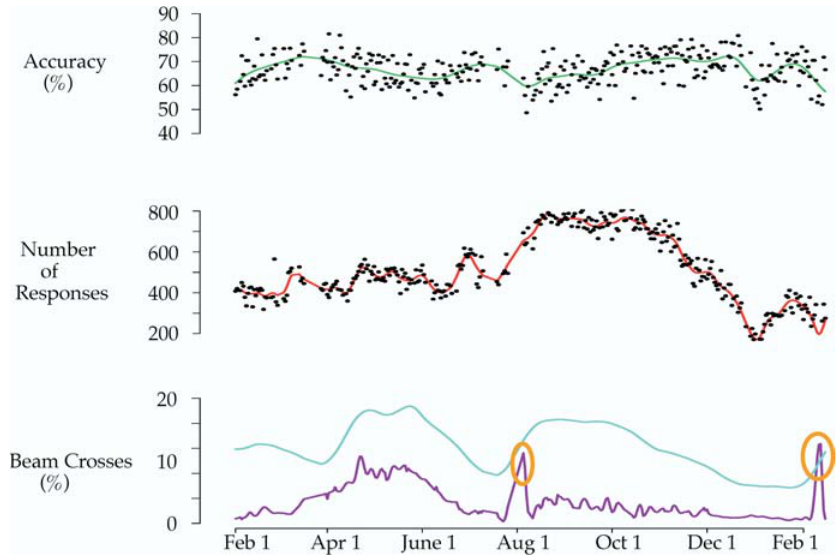
Figure 7. Comparison of Operant Re- sponding and Migratory Behavior The average value for all birds of night- time (purple) and daytime (blue) activity (percentage of 30-s epochs containing at least one infrared beam break) and the accuracy (green) and total number of responses (red) on the acquisition task ( n = 8). As in Figure 1, the sharp high peaks (orange ovals) in early August of 2003 and early February of 2004 mark brief periods of experimenter-induced sleep restriction. DOI: